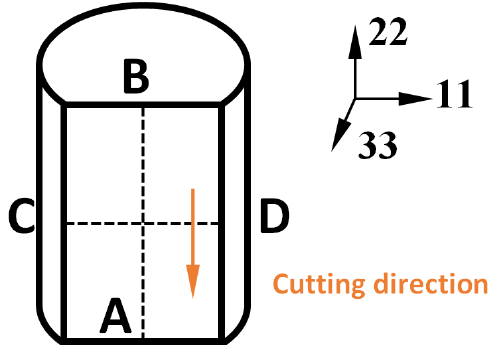
Figure 24. Specimen 1—line segments used for comparing the stress